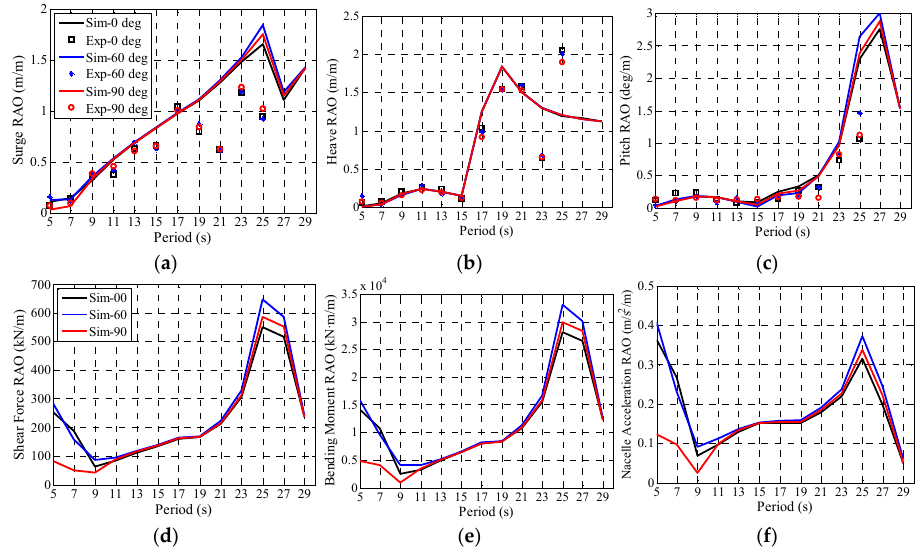
Figure 12. Comparisons of RAOs in three wave headings: ( a ) Surge; ( b ) Heave; ( c ) Pitch; ( d ) Tower base shear force; ( e ) Tower base bending moment; ( f ) Nacelle fore-aft acceleration.